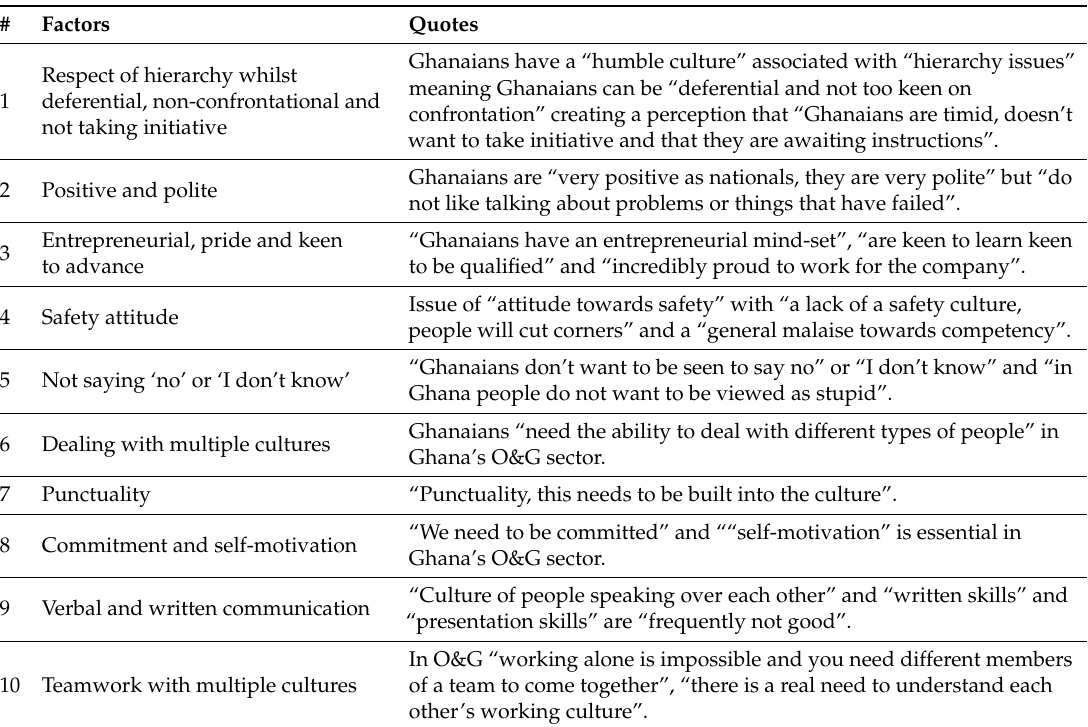
Table 4. ‘Common traits of the Ghanaian workforce’ theme.